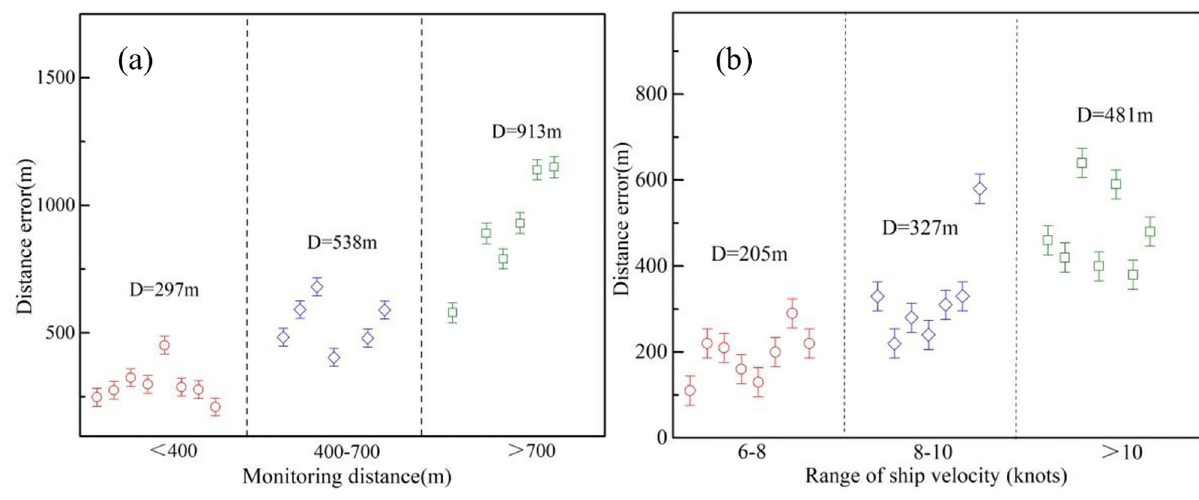
Fig 11. Influence of (a) monitoring distance and (b) ship velocity on the trace model accuracy.